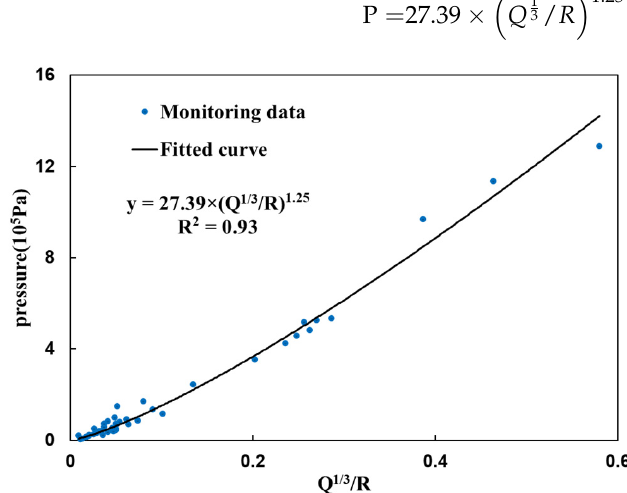
Figure 3. Shock wave monitoring data fitting.